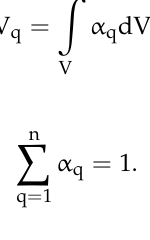
Figure 3. Views of the mesh in vertical longitudinal sections ( a , b ) and transversal longitudinal sections ( c , d